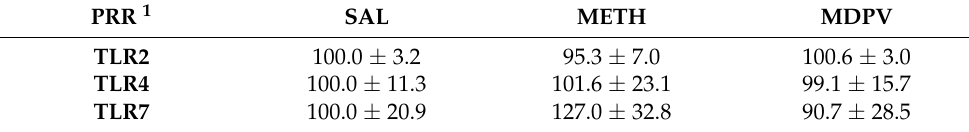
Figure 6. Effect of METH and MDPV binge paradigm on mice striatal RAGE mRNA relative expression, protein density and sub-cellular distribution. ( a ) RAGE mRNA expression, expressed as mean % NRQ of saline ± S.E.M. ( n = 5–7); ( b , c ) Representative western blot and quantification of striatal RAGE proteins with anti-RAGE N-terminal and anti-RAGE C-terminal antibodies, respectively. Results were normalized with GAPDH and expressed as mean % of saline ± S.E.M. ( n = 5–7); statistical comparisons were made using the Kruskal–Wallis test followed by Dunn’s multiple comparison test; ( d ) representative confocal images of striatal sections, co-labelled with anti-RAGE N-terminal antibody (green) and anti-RAGE C-terminal antibody (red). Sections were counterstained with DAPI (blue) for nuclei visualization (scale bar: 40 µ m, n = 3). Table 1. Effect of METH and MDPV binge paradigm on mice striatal TLR protein density.